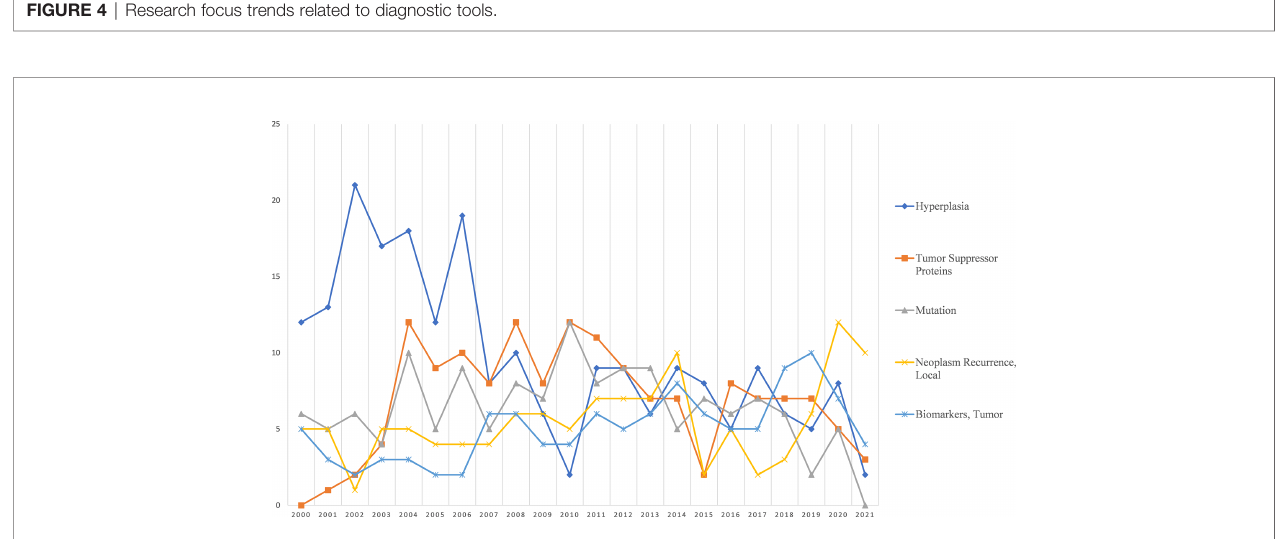
FIGURE 5 | Research focus trends related to basic research.